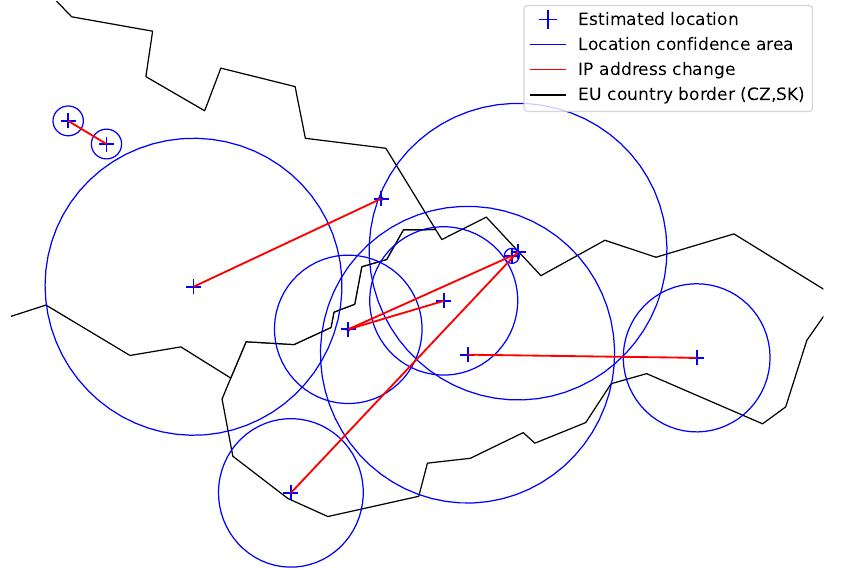
Figure 14. Geographical plot of selected indicated cheatings. Plotted are location confidence areas and distances associated with indication